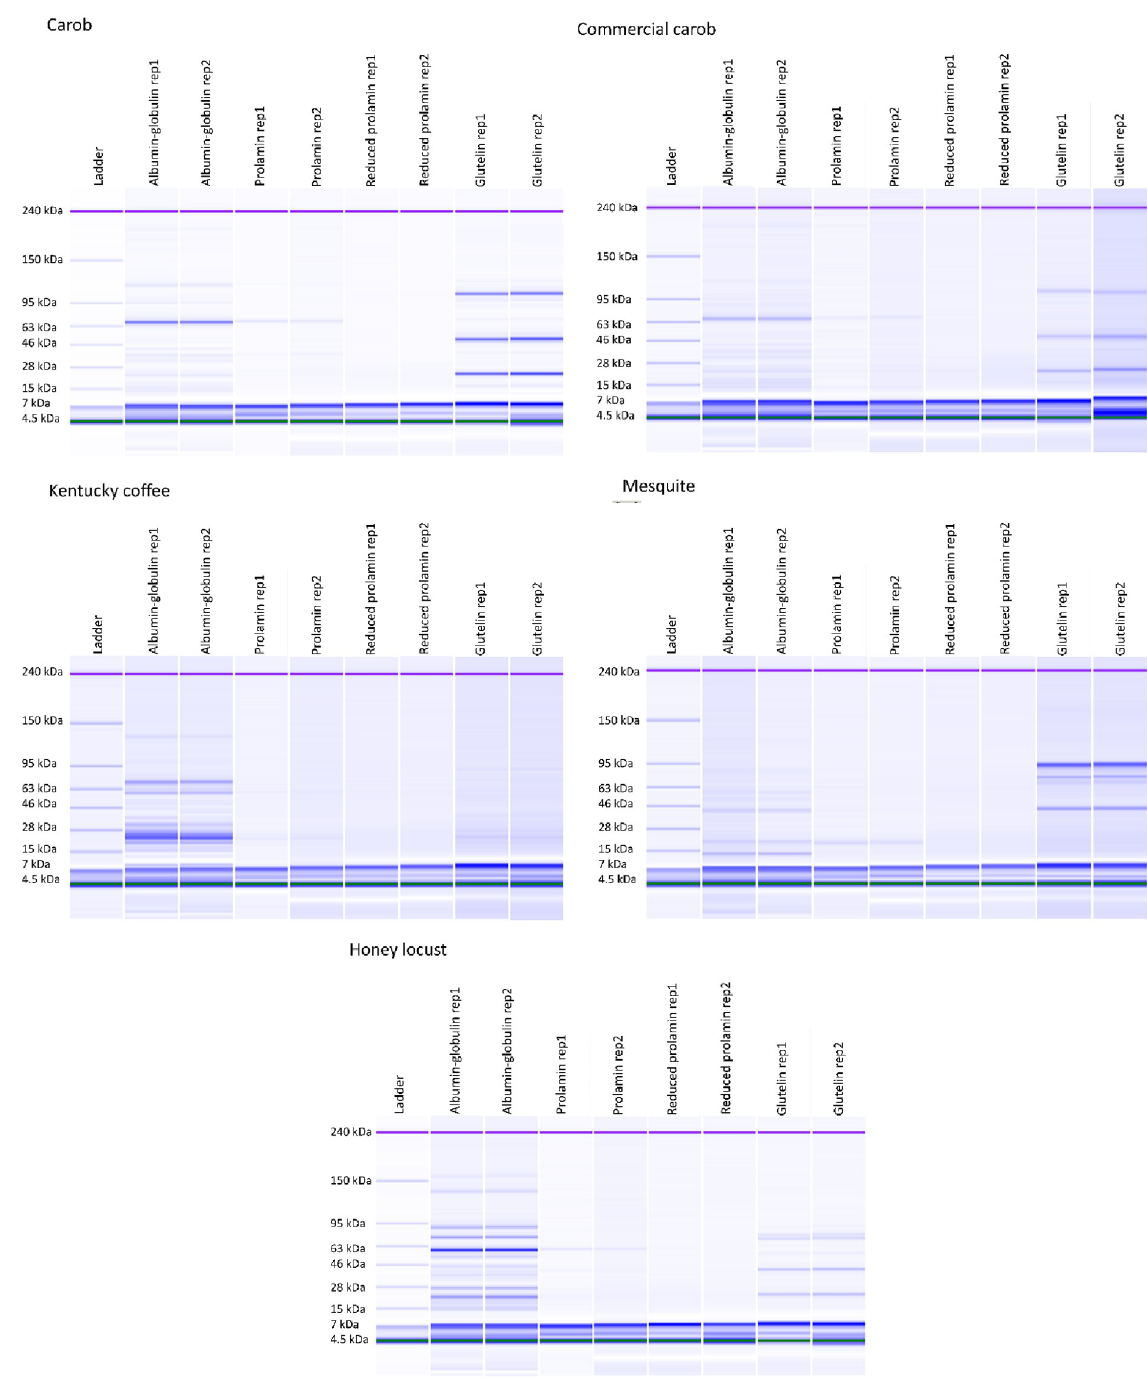
Fig 3. The SDS-PAGE analysis of Osborne fractions. mg/g) comprising 36.6% of total amino acids [17]. Glutamic acid contains a carboxylic acid group attached to the end of the C3 side chain, which provides ionic interaction sites with divalent ions in the dough to stabilize the viscoelastic structure of gluten [17]. Among samples, carob had the highest percentage of glutamic acid (24.7 and 27.6% for carob and commercial